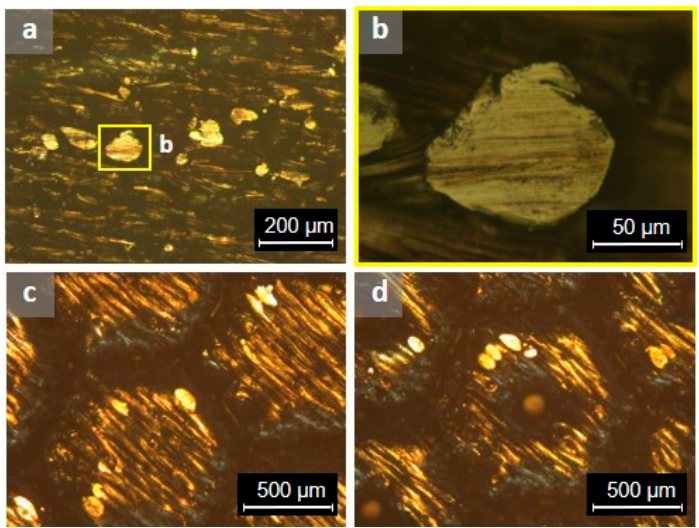
Figure 13. Wear tracks, after 20,000 laps, R13.5_N5_L lubricated tests; ( a , b ) baseline, ( c ) Hex_50 type, ( d ) Hex-D_50 type.